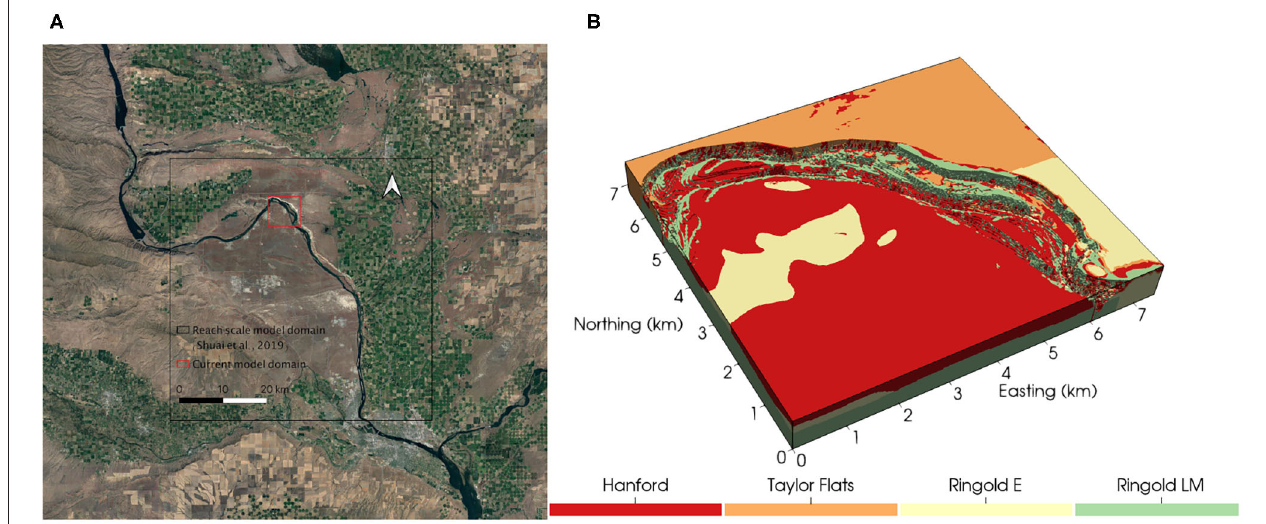
FIGURE 1 | (A) The Hanford reach and the study domain (bounded in red). The reach scale model in Shuai et al. (2019) is bounded in black. (B) Geologic units at the study domain.